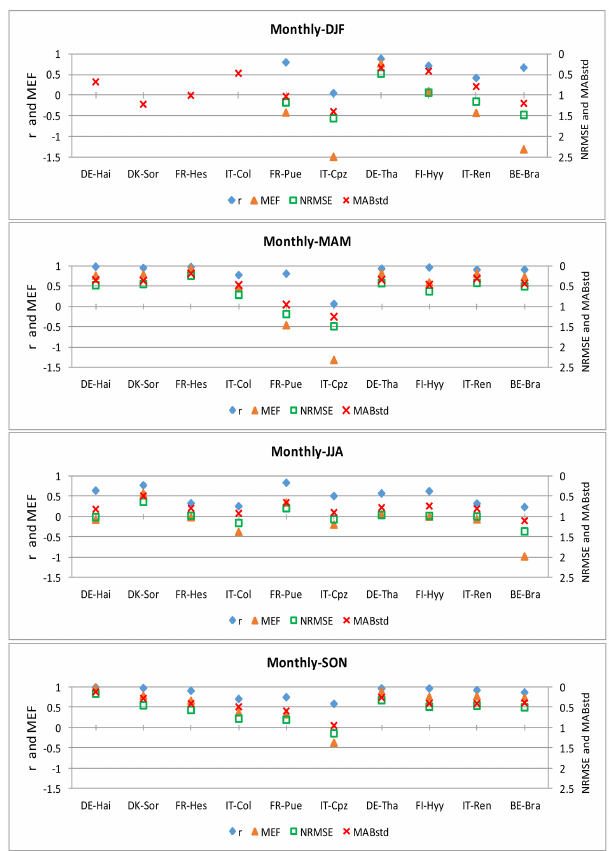
Figure 4. 3D-CMCC FEM performance indices of daily GPP at different seasons. DE-Tha refers to the 1S simulation, IT-Ren to the 2L_ 2C simulation, BE-Bra to the P_Q-3L simulation (see text).